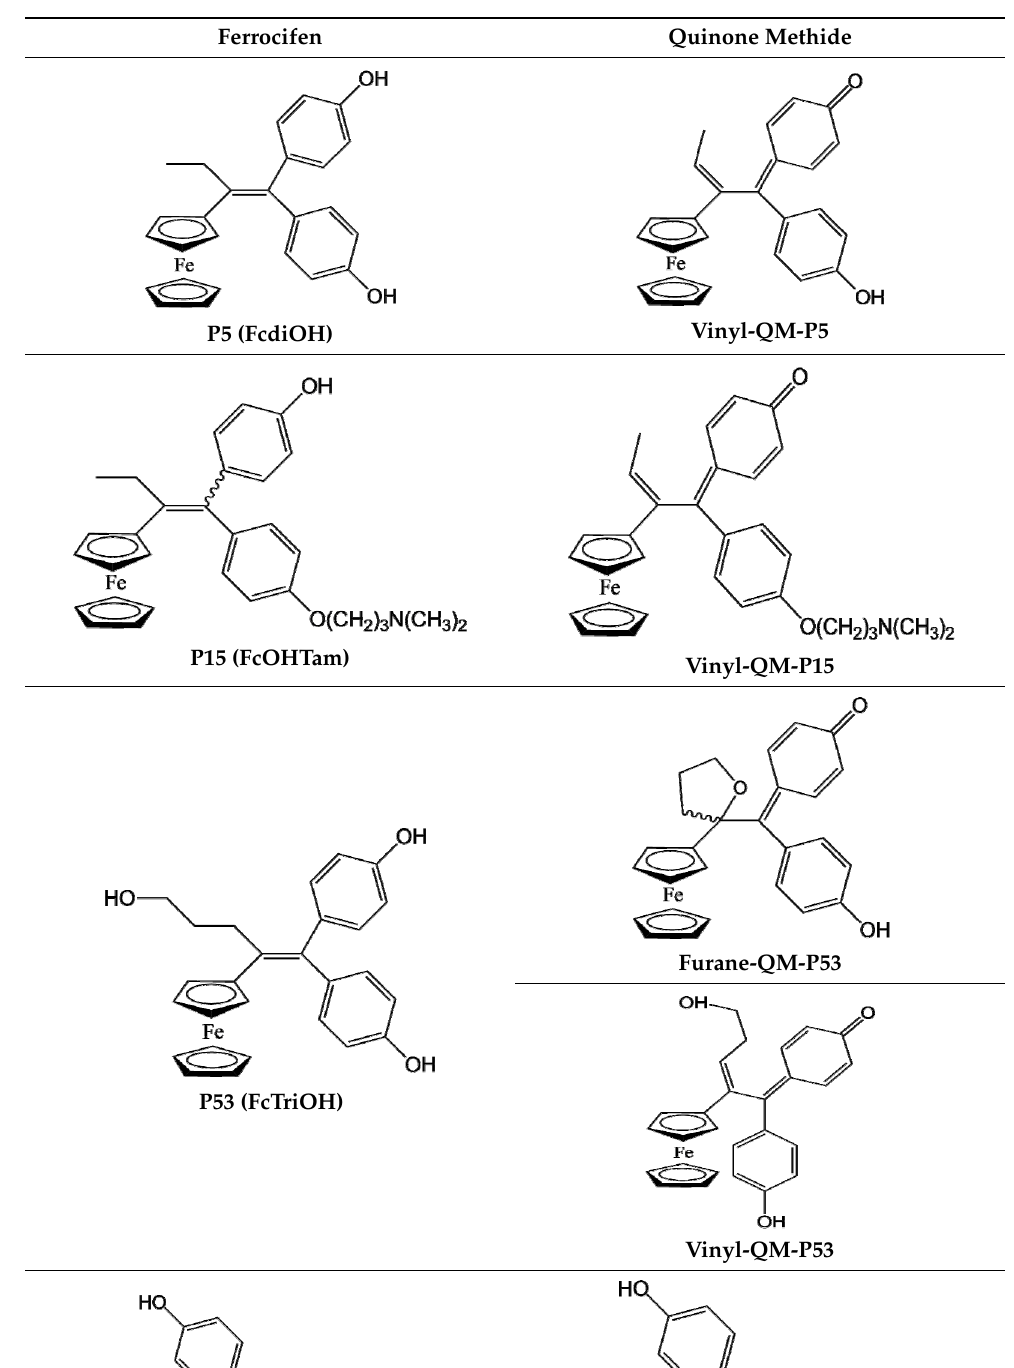
Figure 3. Mechanism of quinone methide formation from ferrocifen. This mechanism was confirmed by electrochemistry and electron paramagnetic resonance. Table 1. Structure of P5, P15, P53, DP1 and P722 ferrocifens and their corresponding quinone methides.